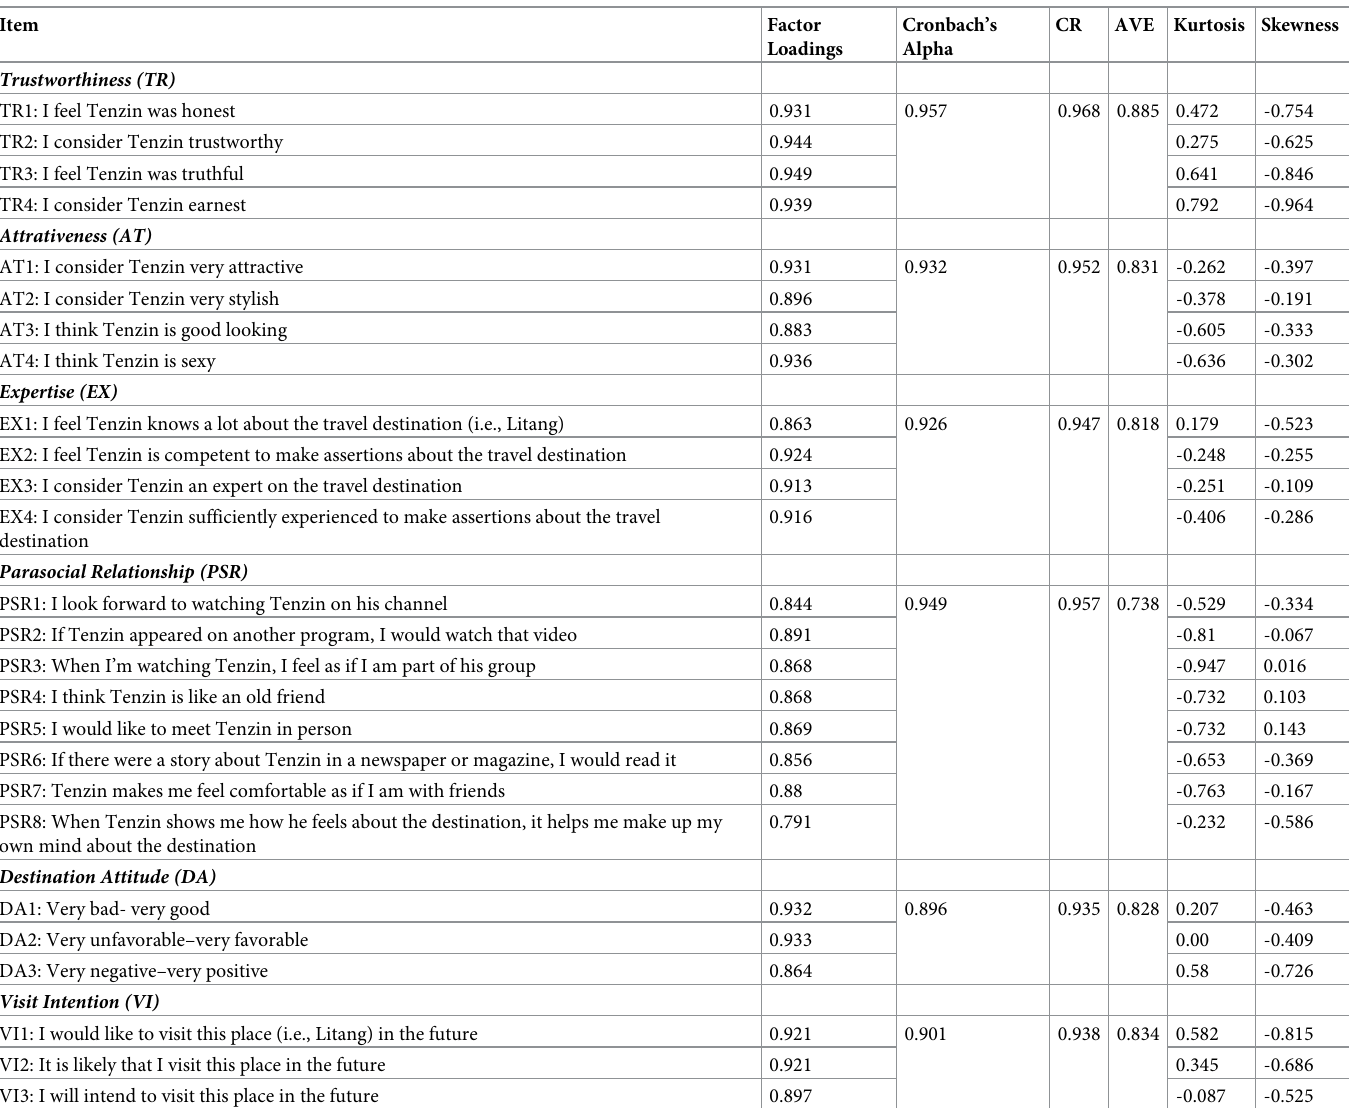
Table 2. Summary for confirmatory factor